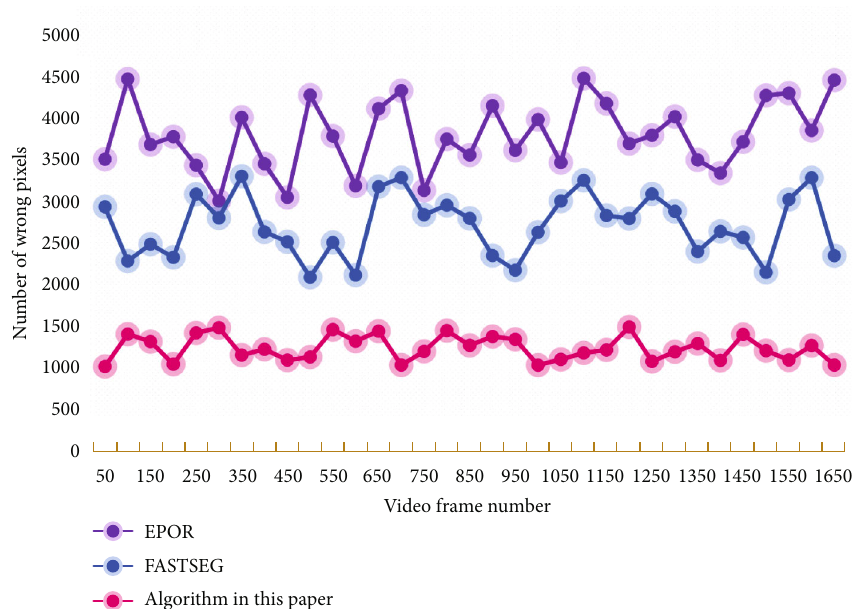
Figure 9: Comparison chart of the number of wrong pixels per